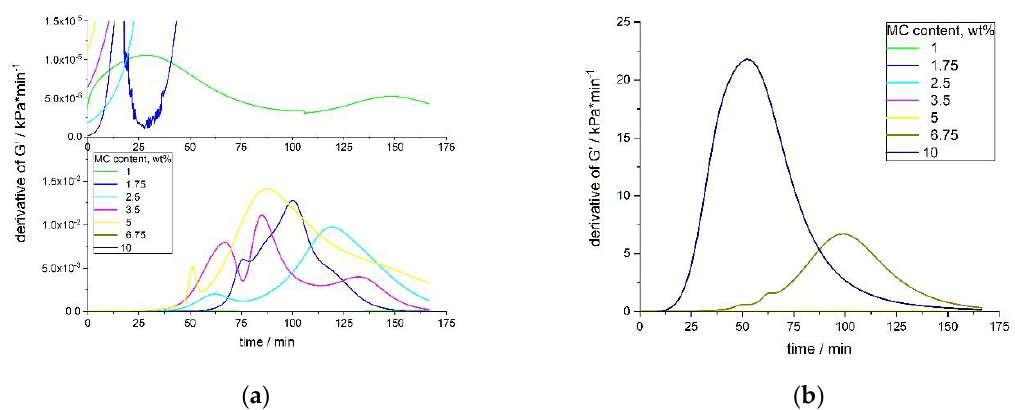
Figure 8. d G’ /dt versus time for several MC solutions — ( a ) enlarged view of low MC concentrations, and ( b ) the whole dG’/dt range .